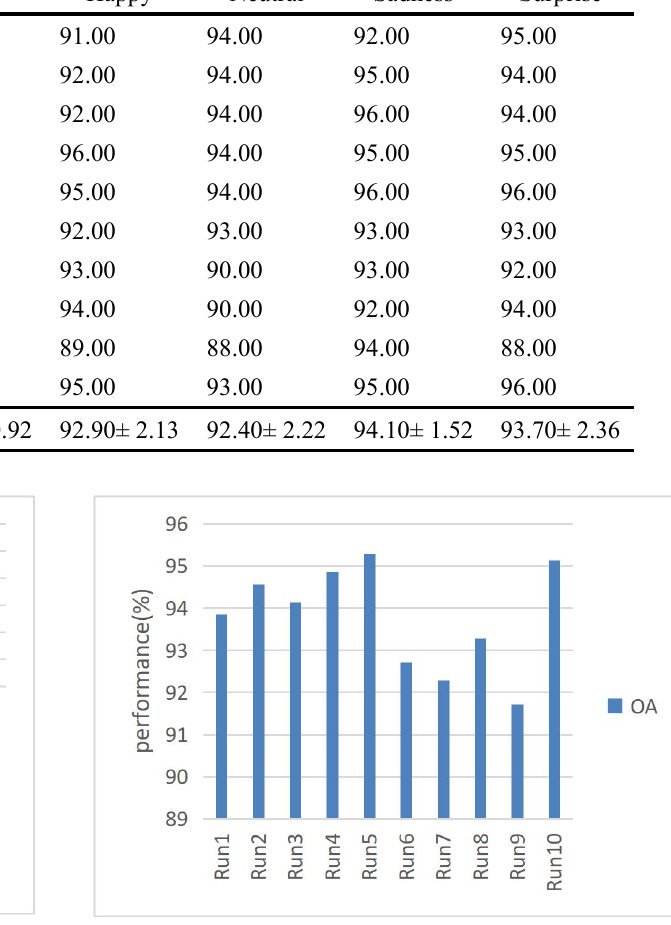
Figure 8. The trend of the sensitivities of each class